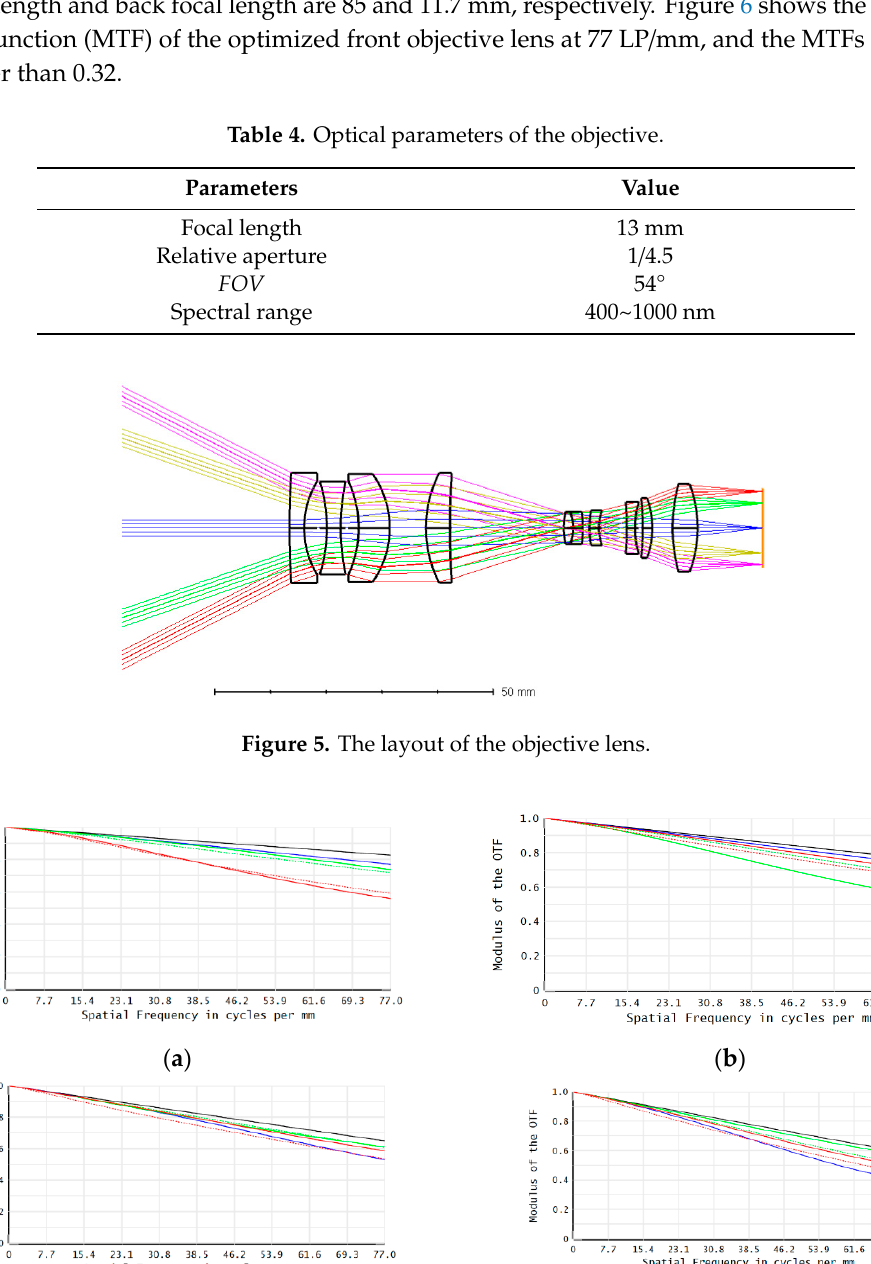
Figure 7. The field curvature and distortion of the objective lens.